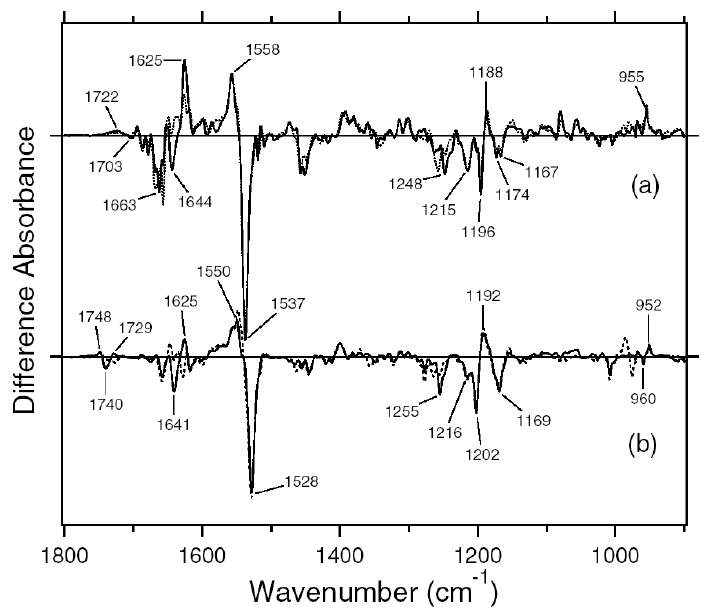
Figure 33. The ASR minus ASR (a) and the BR L the 1,800–900 cm -1 region, which are measured at pH 7 and 170 K upon hydration with H O (solid line) and D O (dotted line), respectively. One division of the y-axis corresponds 2 2 to 0.012 absorbance units. This figure is reprinted with permission from Kawanabe et al [77]. Copyright 2008 American Chemical